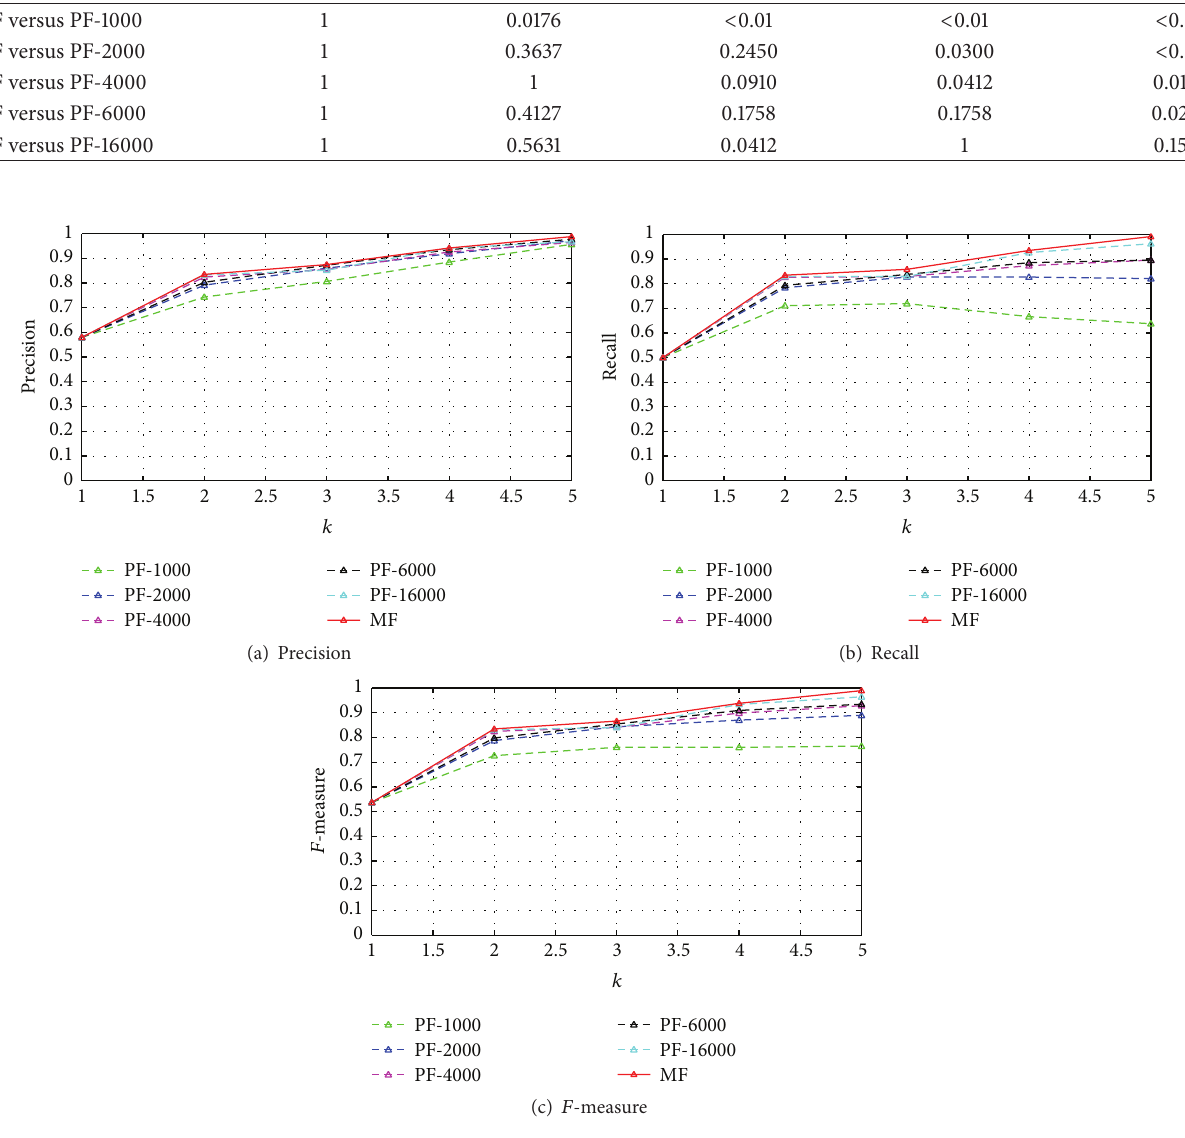
Figure 5: Recognition metrics of the MF and